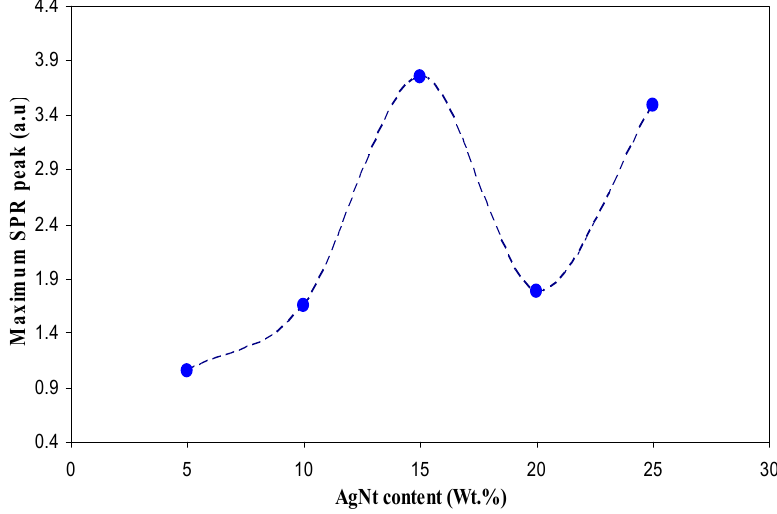
Figure 2. Maximum SPR absorption peak versus salt concentration.